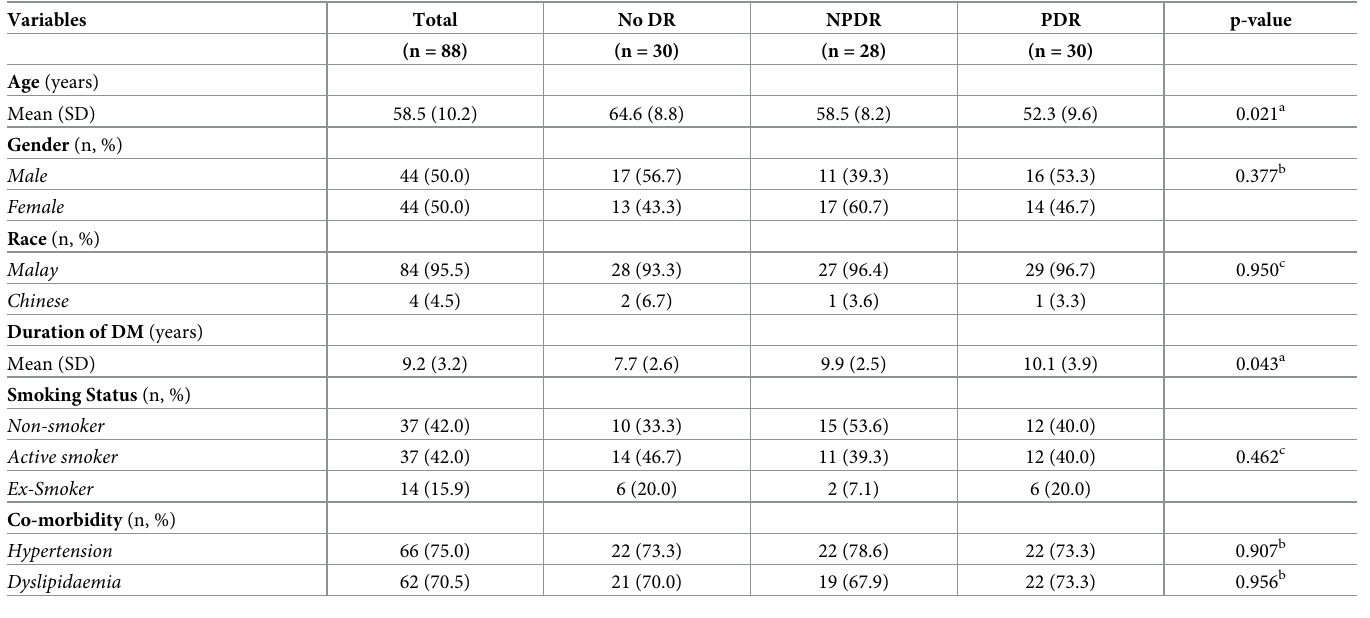
Table 1. Demographic characteristics and systemic profile among type 2 diabetic patients.